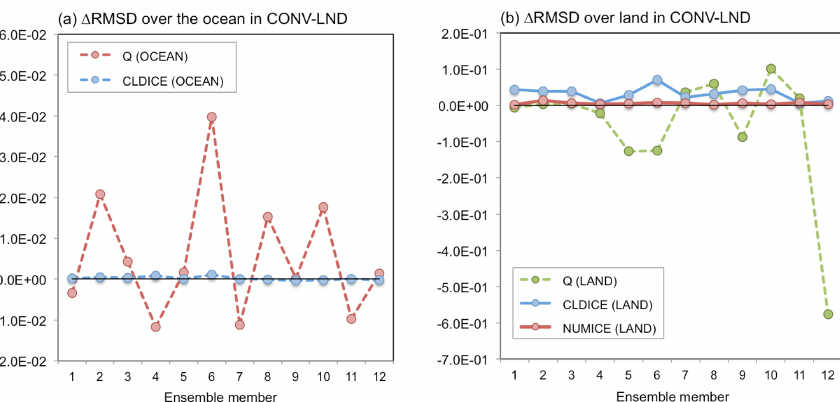
Figure 3. (cid:49) RMSD t,j,m of individual ensemble members after t = 5min of model integration in the “CONV-LND” test case that was designed to fail the TSC test when all variables, domains, and ensemble members are considered (see Table 1 and Sect. 4.2). The values have been normalized by the mean RMSD of the trusted ensemble, i.e., RMSD trusted ,t,j , of the corresponding prognostic variables and domains; (a) ocean and (b) land. Dashed (solid) lines correspond to variables that passed (failed) the TSC test according to the criterion defined by Eq. (6). The prognostic variables shown in the figure are specific humidity ( Q ), grid-box mean ice crystal mass concentration in stratiform clouds (CLDICE), and grid-box mean ice crystal number concentration in stratiform clouds